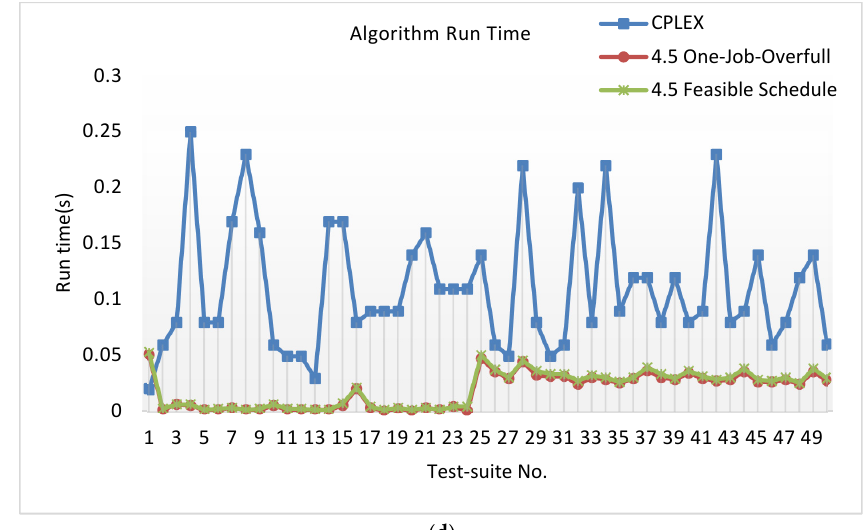
Figure 3. Results of J1M1S1P1K1. ( a ) Comparison makespan of CPLEX and the 4.5-approximation algorithm with one-job-overfull batches and the 4.5-approximation algorithm with a feasible schedule. ( b ) Comparison makespan of the 4.5-approximation algorithm with one-job-overfull batches and 9 T /4. ( c ) Comparison makespan of the 4.5-approximation algorithm with a feasible schedule and 4.5 T . ( d ) Comparison running time of CPLEX and the 4.5-approximation algorithm with one-job-overfull batches and the 4.5-approximation algorithm with a feasible